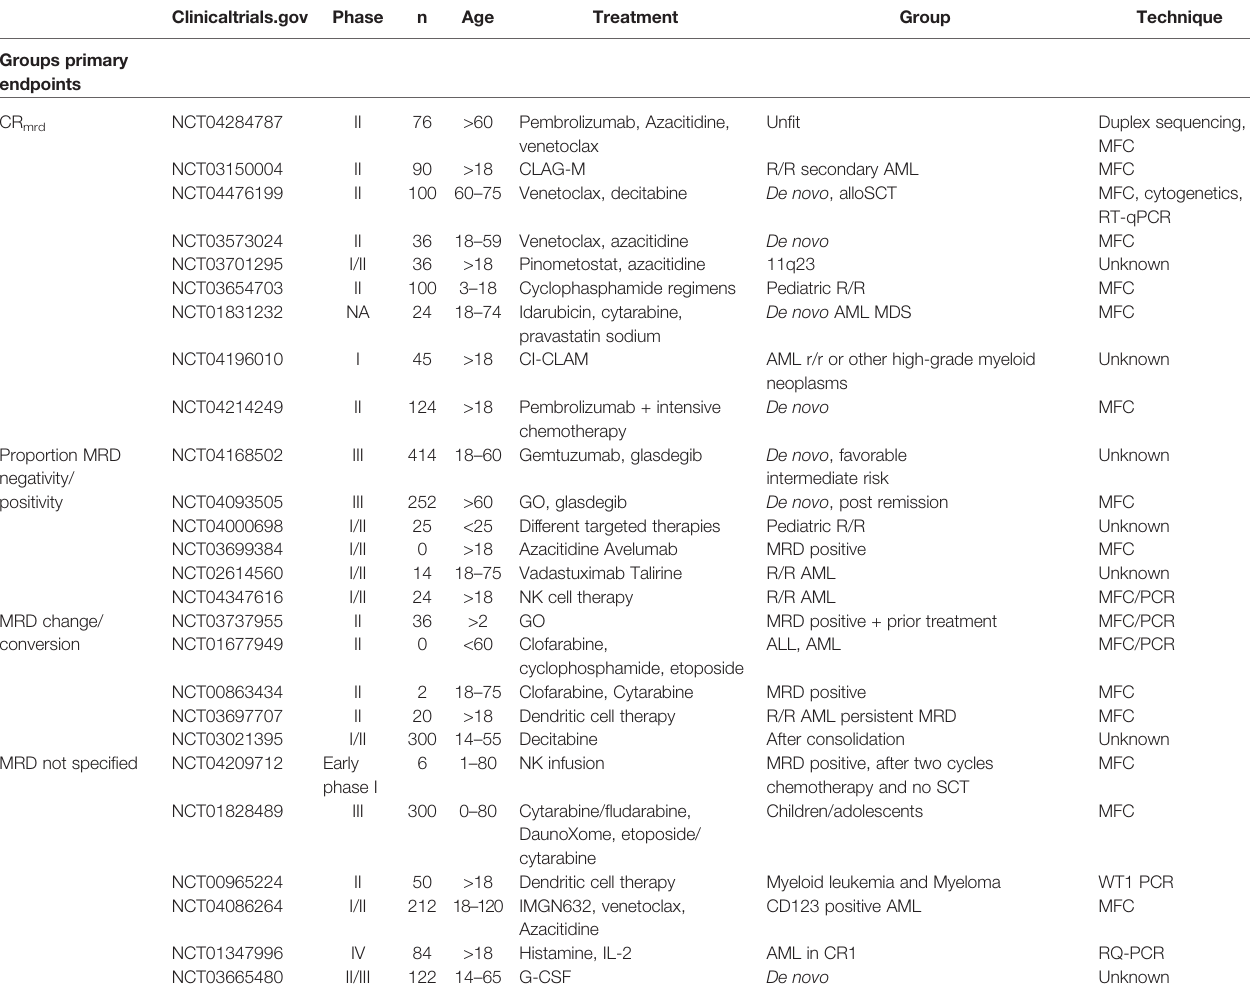
TABLE 3 | Current trials using MRD as a primary endpoint. Clinicaltrials.gov